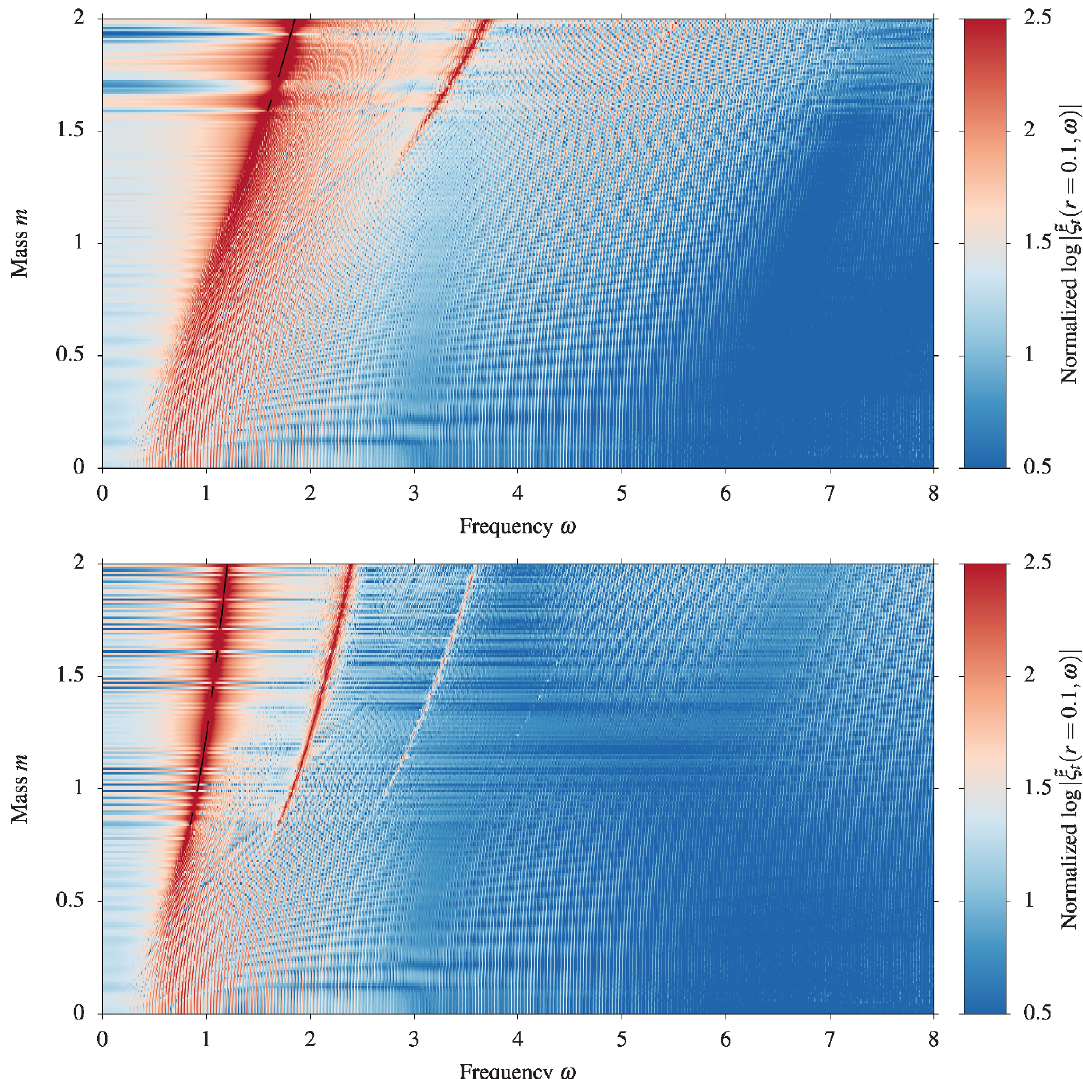
(1) (upper Skyrme model with potential L 024 U [0 ; 2]. The black 2